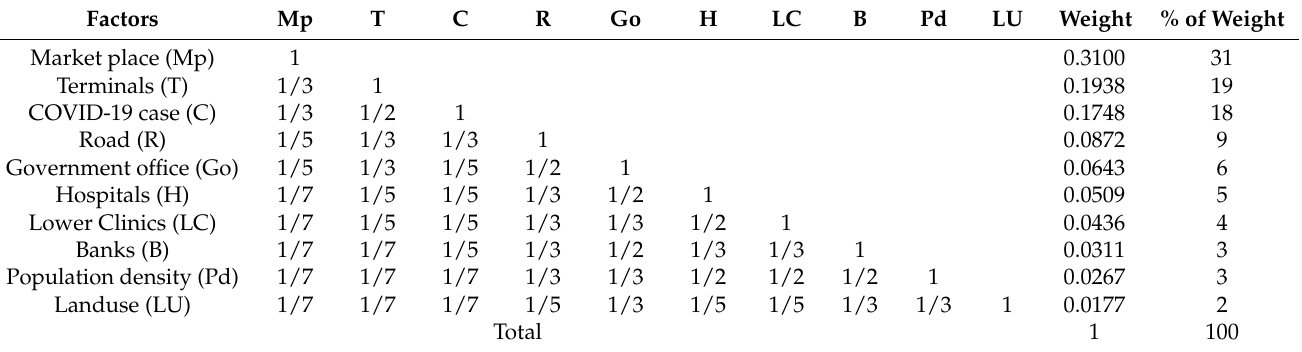
Table 5. Factors and their eigenvectors weights.